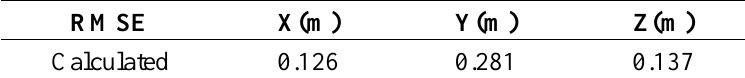
Table 4. RMSE for indoor positioning.